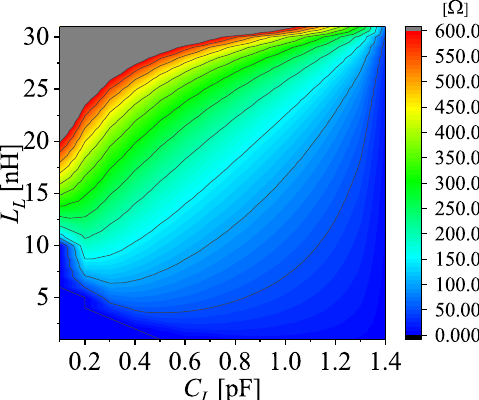
Fig. 6. Phase shift difference between 1.5 and 2GHz depending on C L and L L .